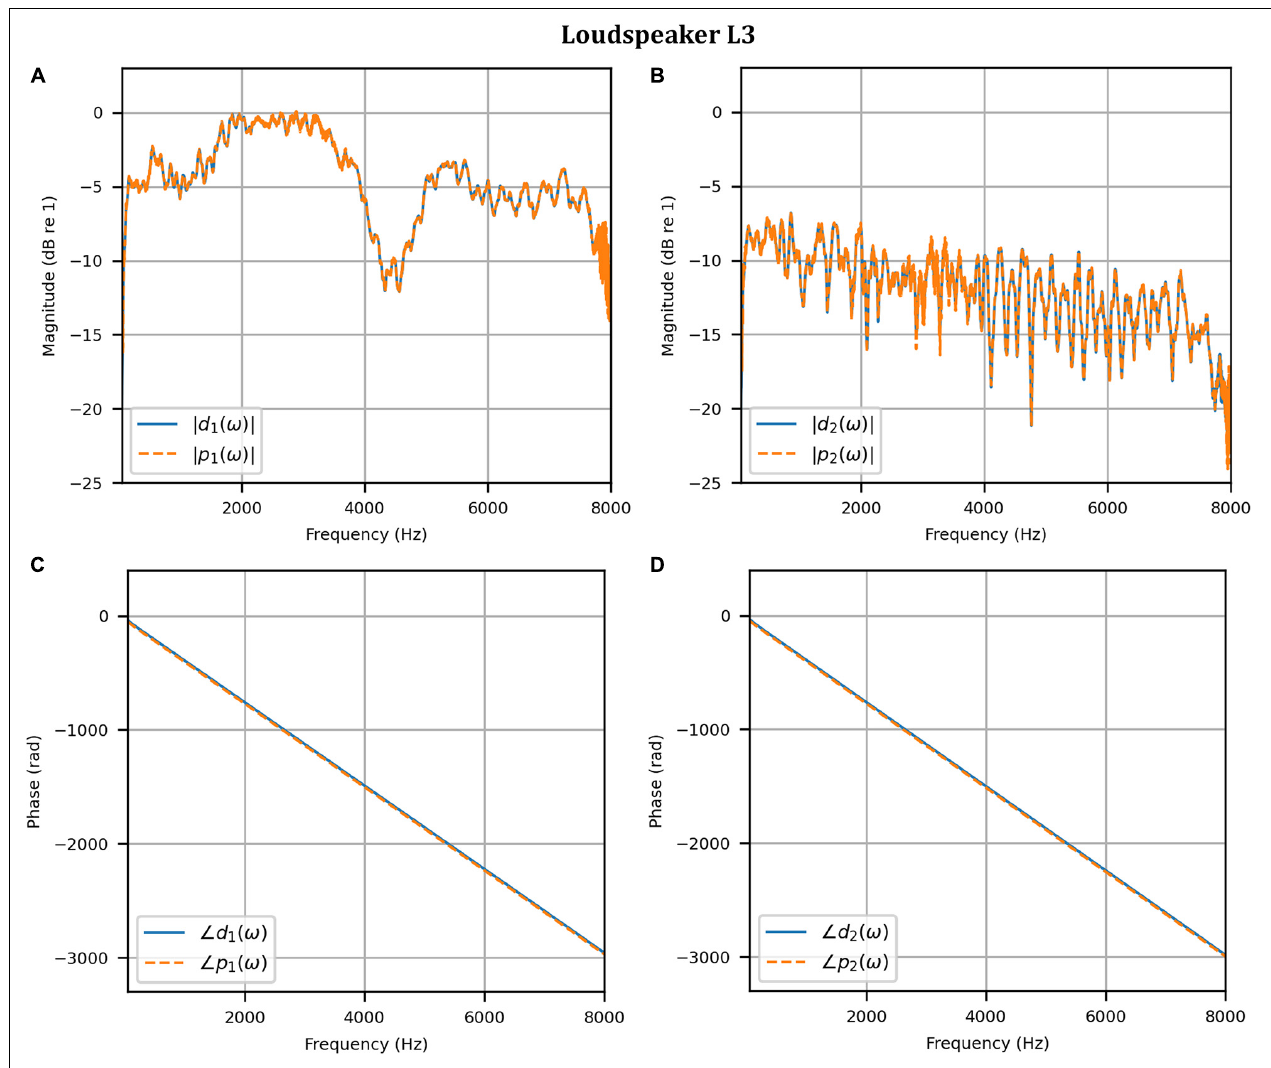
FIGURE 11 | Clinical booth: Target L3 anechoic HADRTF (blue solid) versus reproduced (red dashed) frequency responses: (A) Magnitude responses at the left microphone; (B) Magnitude responses at the right microphone; (C) Phase responses at the left microphone; (D) Phase responses at the right